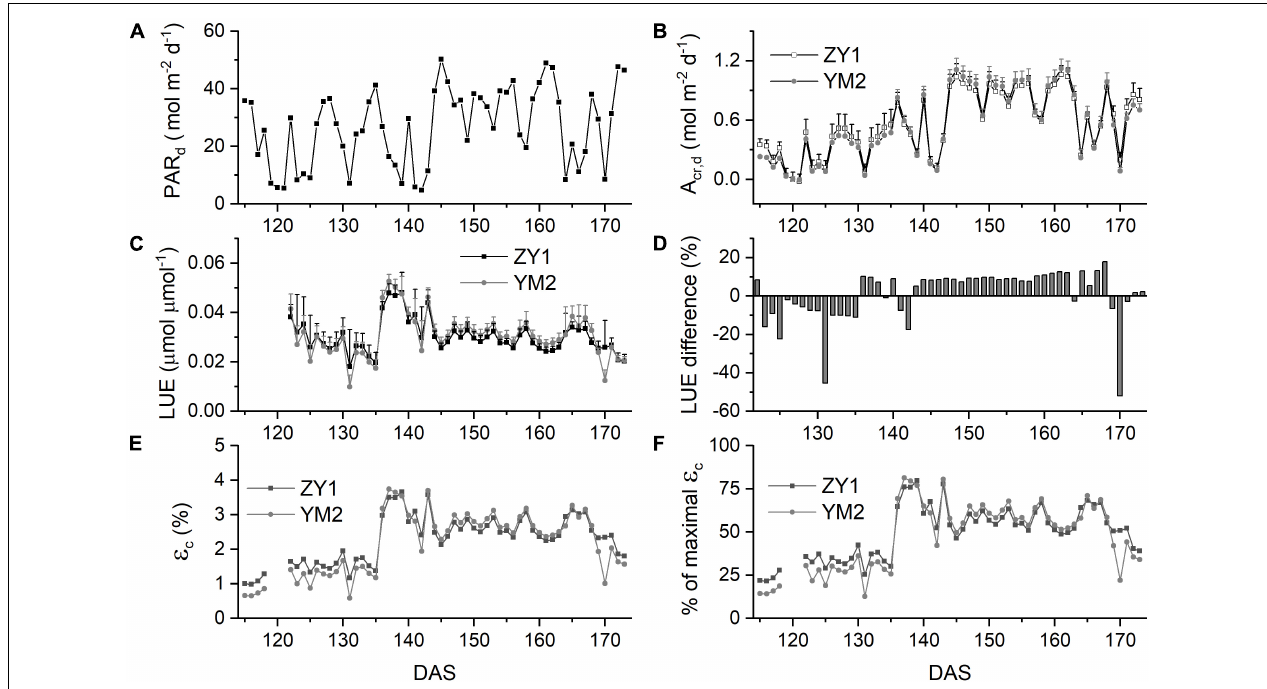
FIGURE 5 | Canopy photosynthesis properties for two field-grown wheat cultivars. Daily total photosynthetically active radiation (PAR d ) (A) , daily whole plant CO 2 uptake rate (A cr , d ) (B) , and light use efficiency (LUE) (C) of ZY1 and YM2 for each day from the tillering stage to the late grain filling stage. The difference of LUE between ZY1 and YM2, calculated as (YM2-ZY1)/ZY1*100%, is shown in panel (D) . Energy conversion efficiency ( ε c ), i.e., calculated as the energy stored in biomass over total incident solar radiation for each day is shown in panel (E) . The percentage of ε c for two cultivars to the maximal ε c was shown in panel (F) . Data in panels (C,D) are shown as mean ± SD ( n = 3 plots).